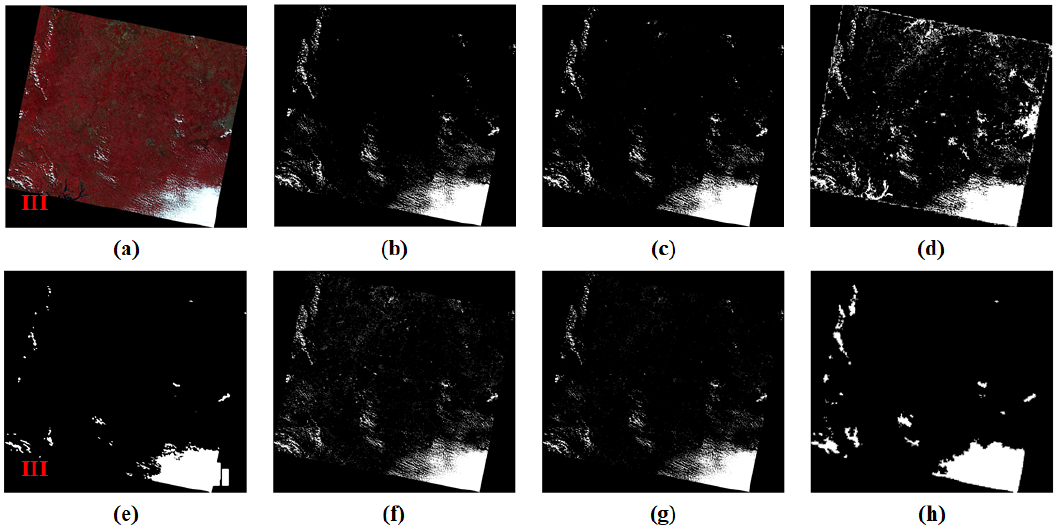
Figure 6. Cloud detection maps of the compared methods: ( a ) Input images labeled III from the GaoFen-1 (GF-1) wide field of view (WFV) dataset, ( b ) reference detection map, ( c ) proposed, ( d ) K-means, ( e ) PRS, ( f ) PCANet, ( g ) SVM, and ( h )